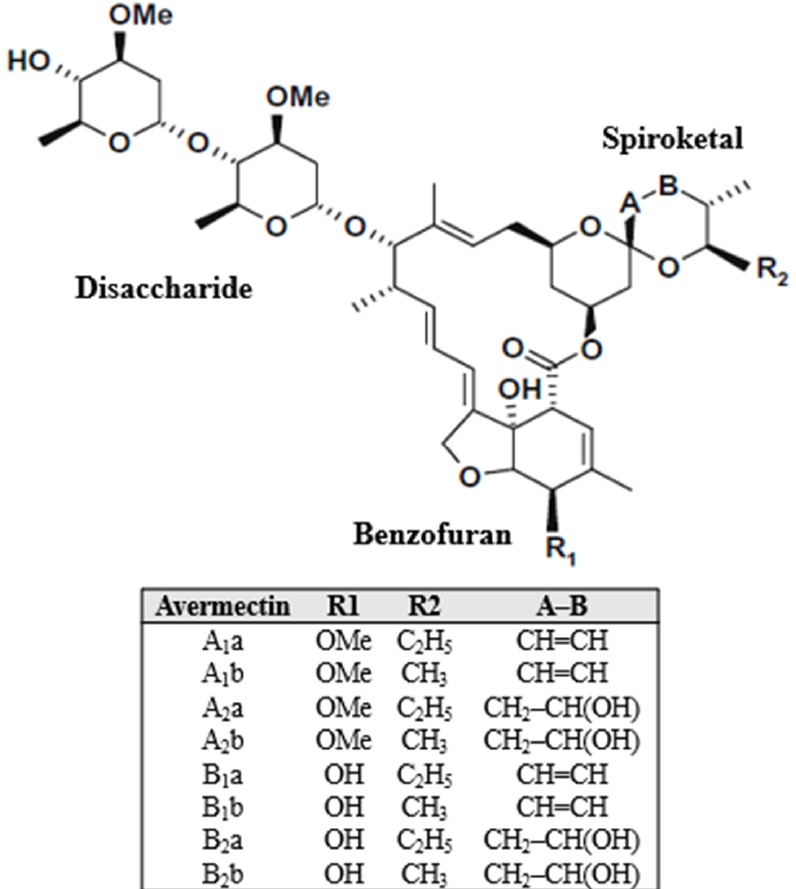
Figure 1. General structural outline of avermectins.